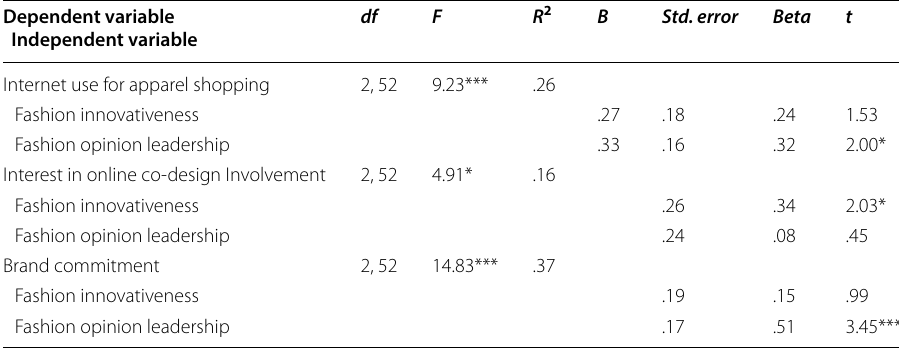
n 53 (listwise deletion); * p < .05; ** p < .01; *** p < .001 (two‑tailed) =